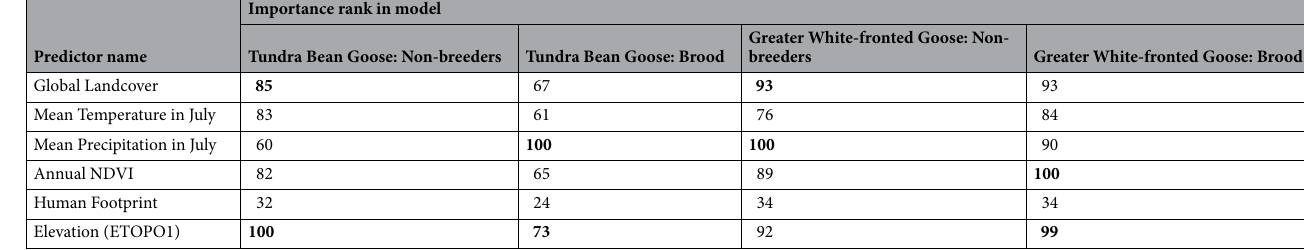
Table 2. Predictor Importance Rank in model for two Anser species: brood-rearing parents with broods and moulting non-breeders (The top-2 predictors for each species strata are presented in bold. Human population density shows little variation and relevance for the study area and is not shown).